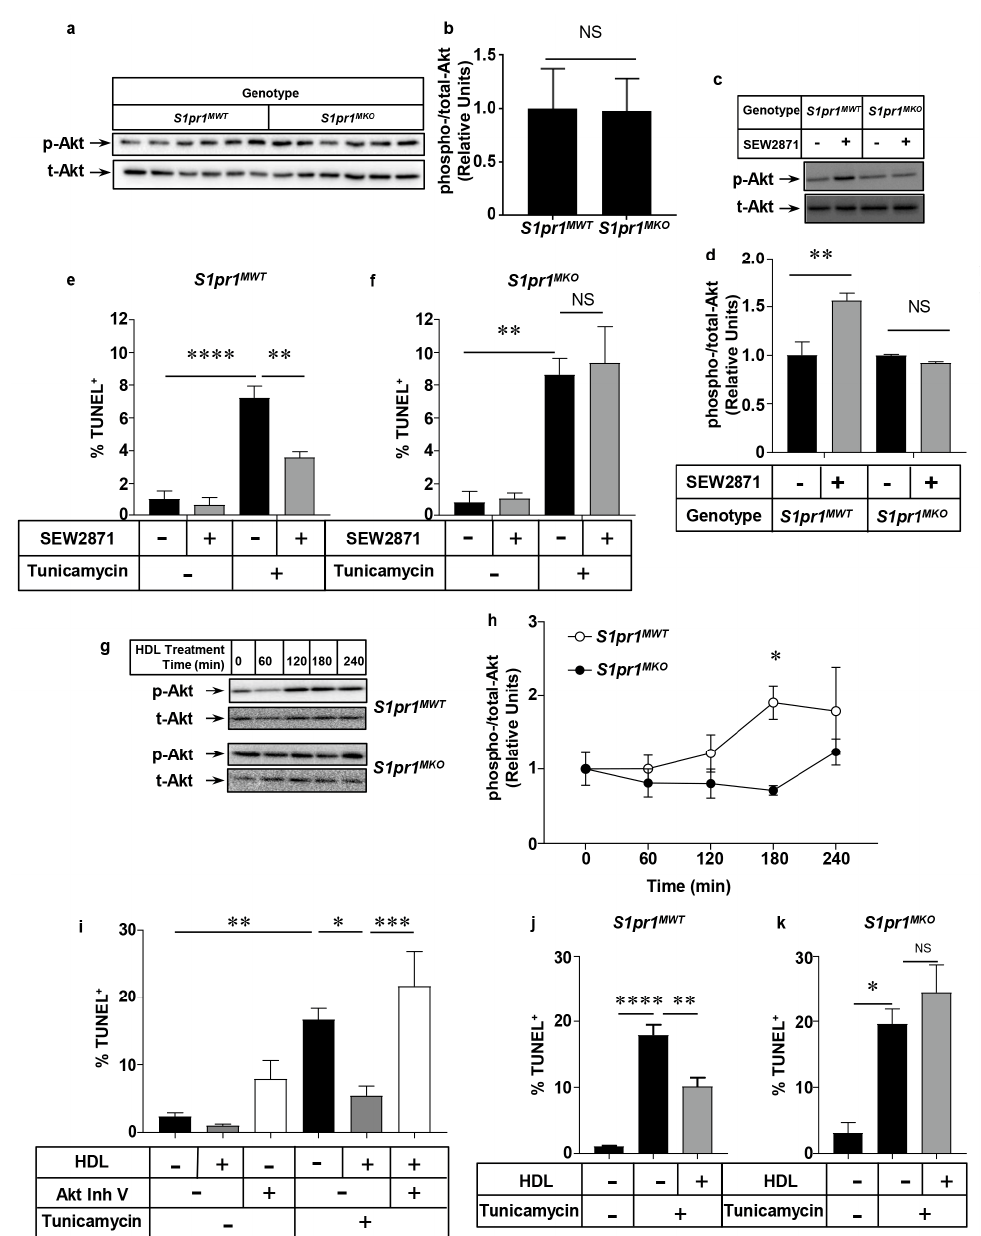
Figure 7. Inactivation of S1pr1 expression in macrophages prevents SEW2871- or HDL-stimulated Akt phosphorylation and protection against tunicamycin-induced apoptosis. Thioglycollate-elicited peritoneal macrophages, prepared from S1pr1 MKO and control S1pr1 MWT mice were either